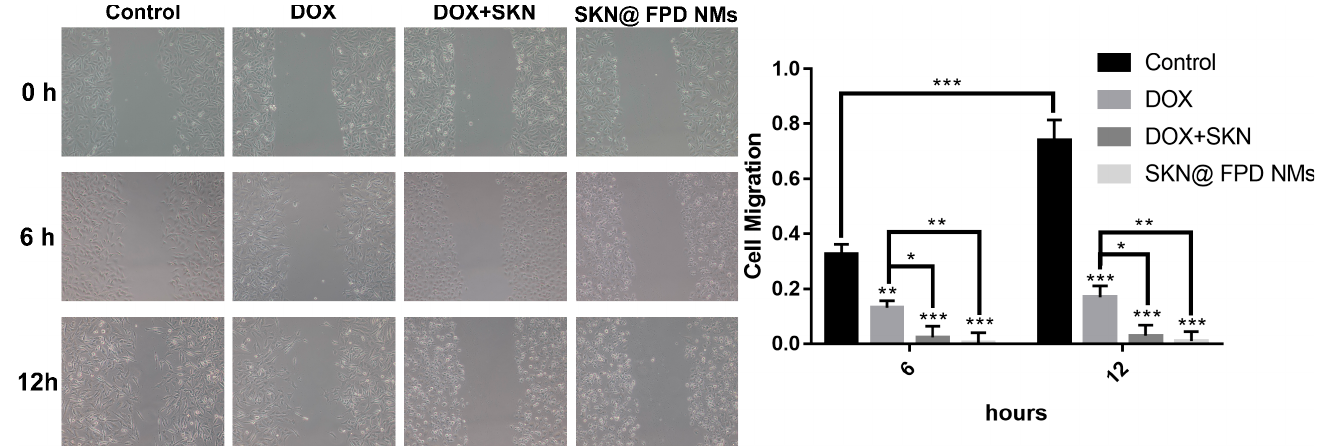
Figure 8. Wound healing experiments using the MDA-MB-231 cells after treatment with DOX, free dual drugs, and SKN@FPD NMs. * p < 0.05, ** p < 0.01, *** p < 0.001. dual drugs, and SKN@FPD NMs. * p < 0.05, ** p < 0.01, *** p <